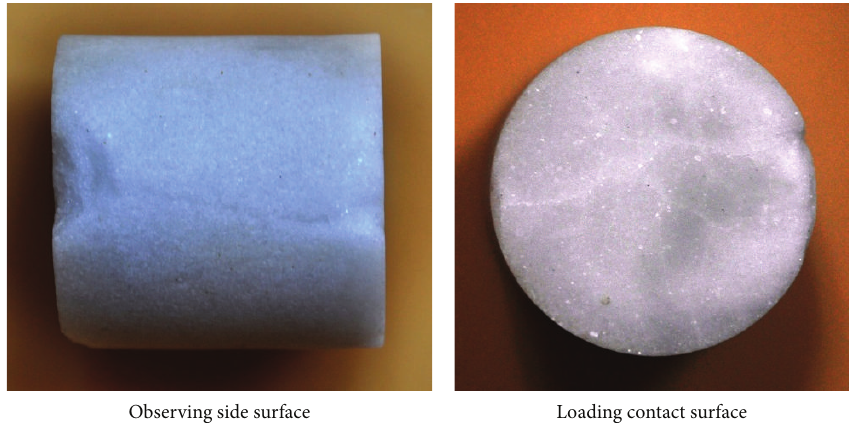
Figure 11: Visible surface cracks of cylindrical marble specimen under certain impact load by